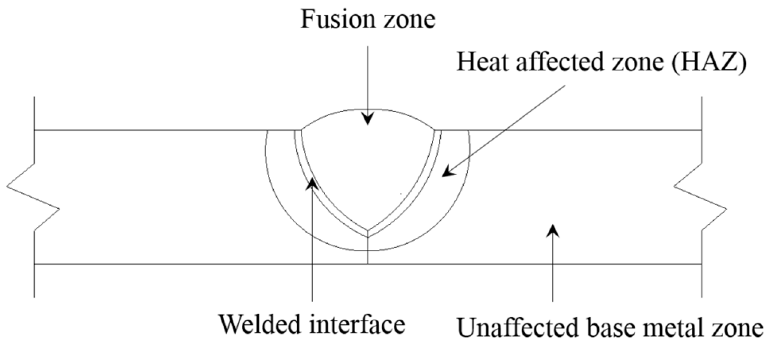
Figure 1. Cross section of a typical welded joint.